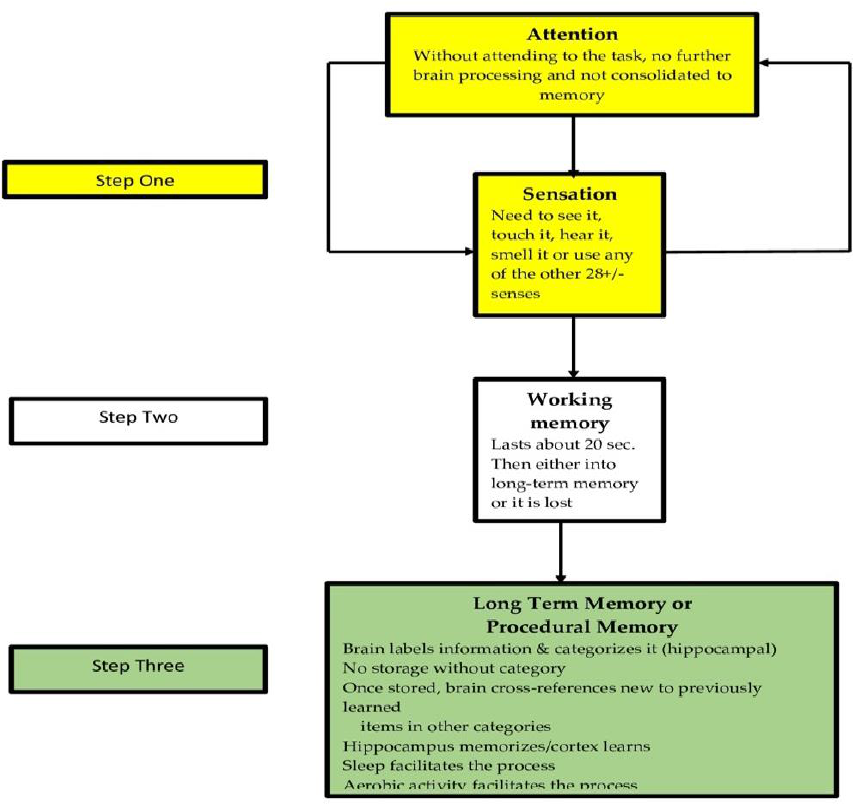
Figure 7. The key to teaching is to help students put things into memory and then retrieve the in-